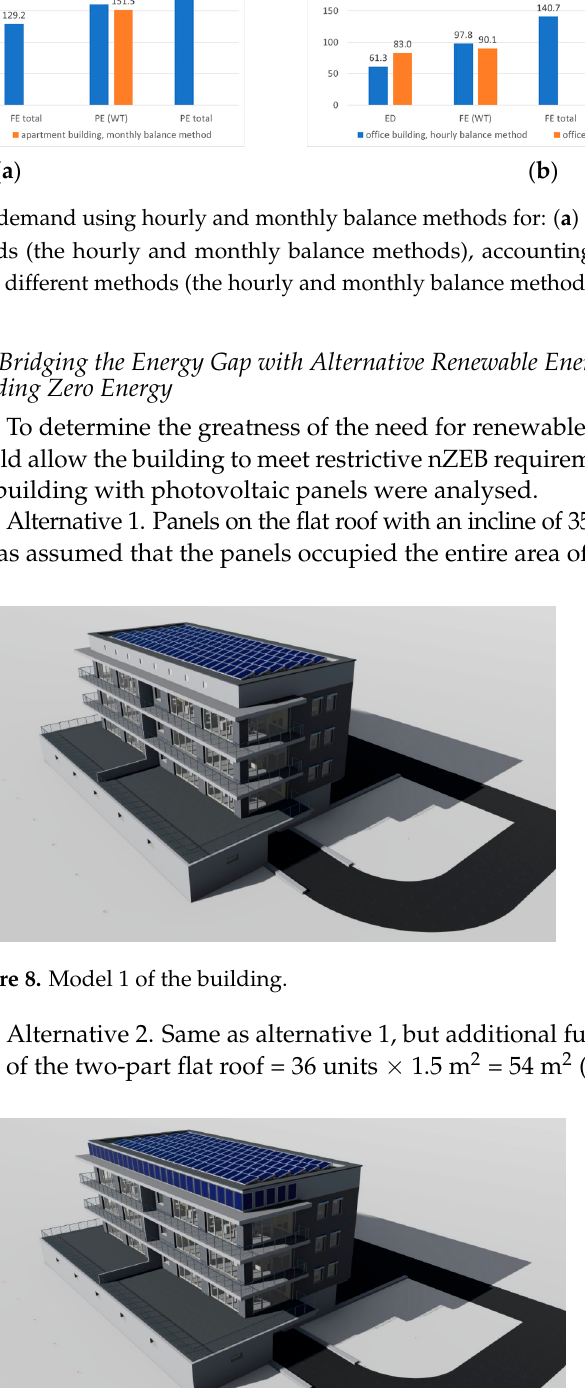
Figure 9. Model 2 of the building.